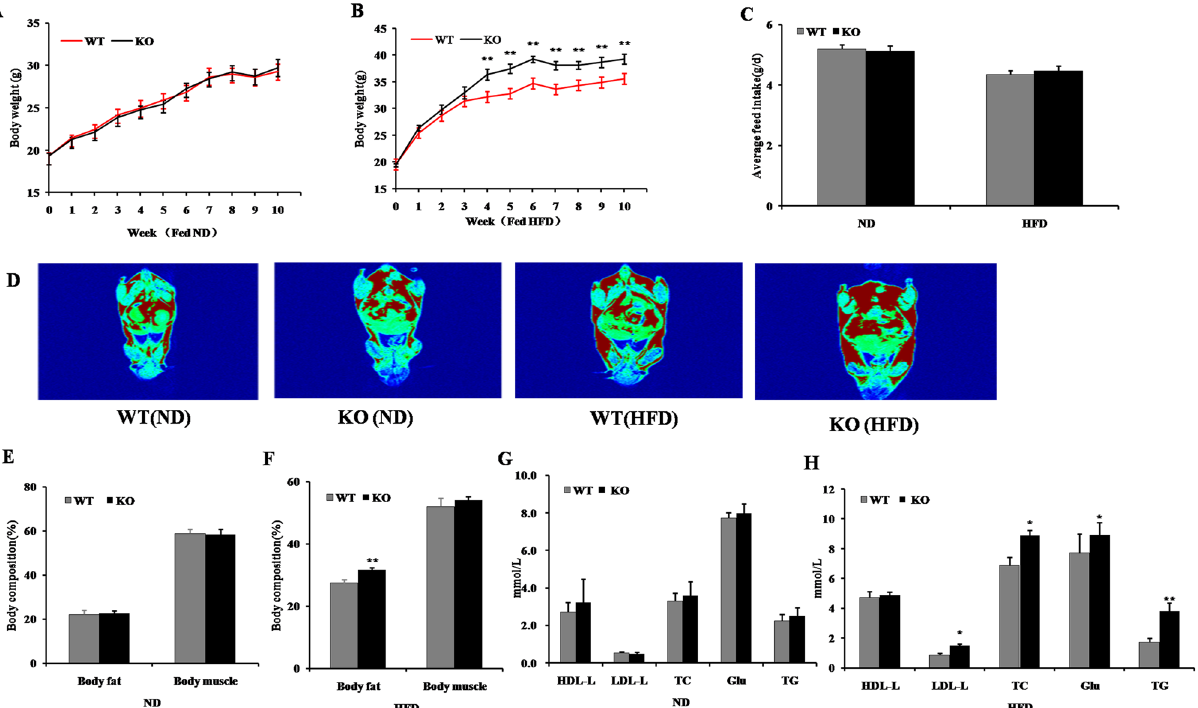
Figure 1. MiR-125b-2 knockout increased HFD-induced obesity . ( A ) The body weight (BW) between WT and KO mice fed a ND was not significantly different ( P > 0.05). ( B ) MiR-125b-2 knockout promotes HFD-induced obesity in male mice. ( C ) Feed intake between WT and KO mice fed ND and HFD. ( D ) Body imaging results of body fat distribution in WT and KO mice fed ND or HFD. ( E ) The body fat and body muscle content in WT and KO mice in the ND group. ( F ) The body fat and body muscle content in WT and KO mice in the HFD group. ( G ) The serum HDL-L, LDL-L, TC, GLU, and TG contents of WT and KO mice fed ND or ( H ) HFD. Data are presented as mean ± SE (* P < 0.05, ** P < 0.01 , n = 8 mice per